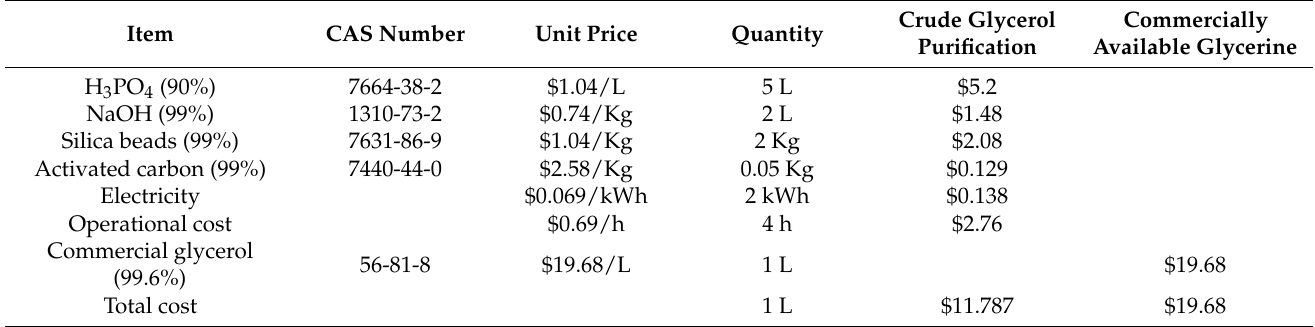
Table 4. Properties of purified glycerol and commercially available